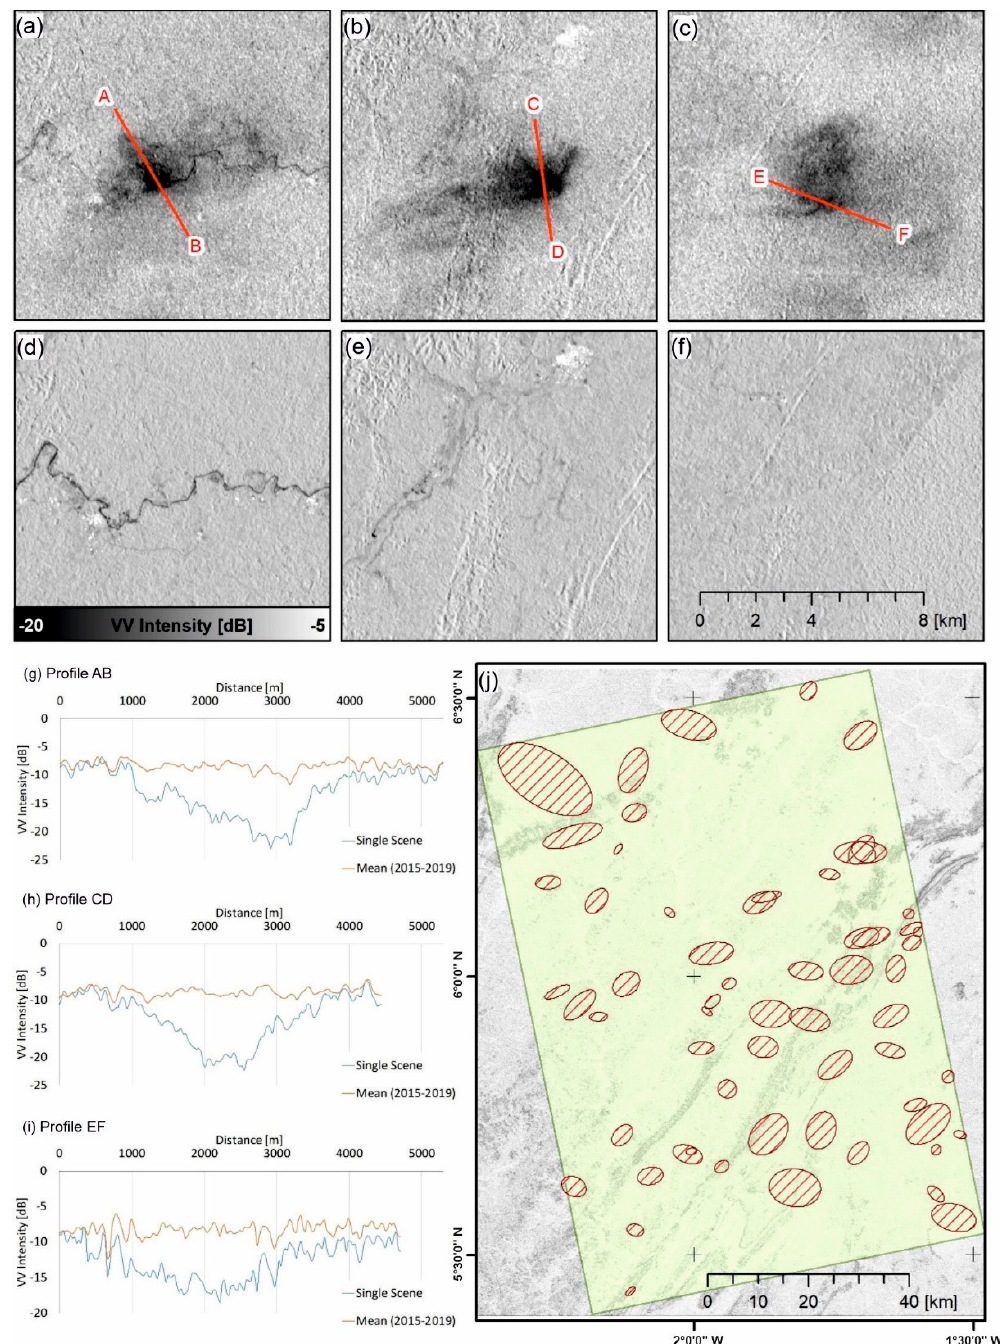
Figure 4. Examples of locally-restricted patches showing strong local decrease in backscatter intensity in the Sentinel-1 time series (2015–2019): ( a ) VV Intensity 2 March 2017, ( b ) VV Intensity 23 October 2018, ( c ) VV Intensity 8 February 2019; ( d – f ) Mean VV Intensity (2015–2019), ( g – i ) intensity values along profiles AB, CD, and EF, and ( j ) locations (dashed polygons) where patches were detected within the study area (extent shown in green color, see Figure 1) for the full time series (2015–2019). Background map in ( j ) draws the slope of the SRTM Digital Elevation Model.